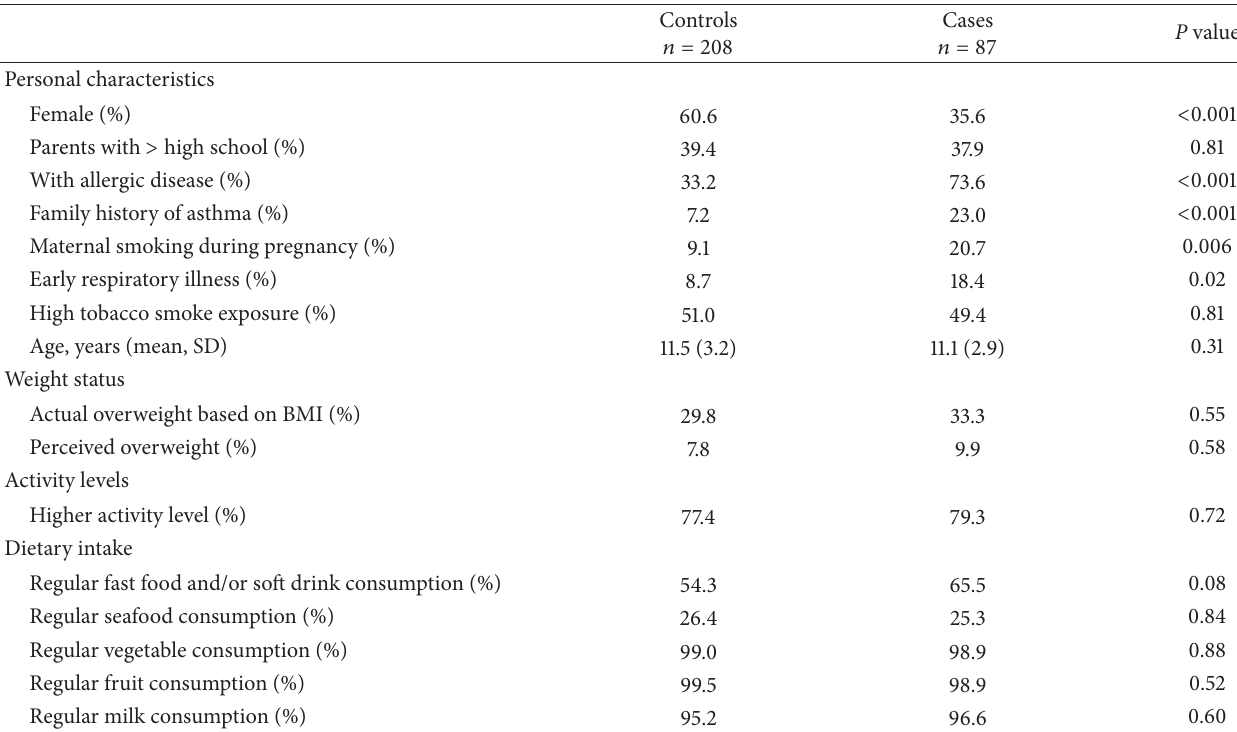
Table 1: Characteristics of the cases and